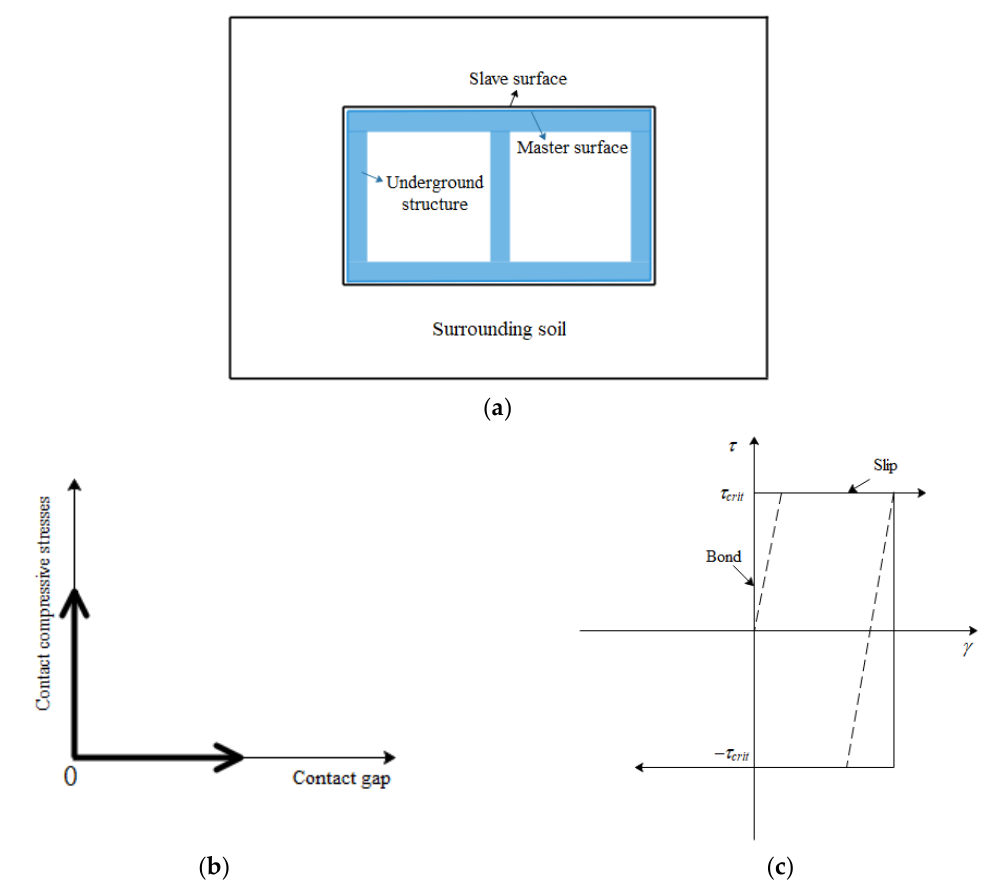
Figure 7. Models of dynamic contact behavior between soil and underground structure: ( a ) master–slave surface relationship; contact behavior in ( b ) normal and ( c ) tangential directions.